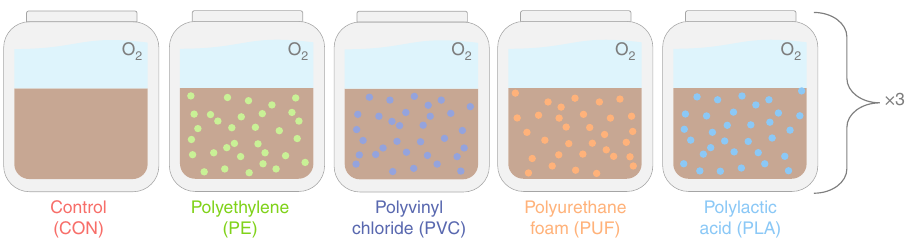
Fig. 1 Microcosm experimental design. All fi ve treatments were repeated in triplicate and each microcosm was individually aerated to establish an oxygen gradient in the